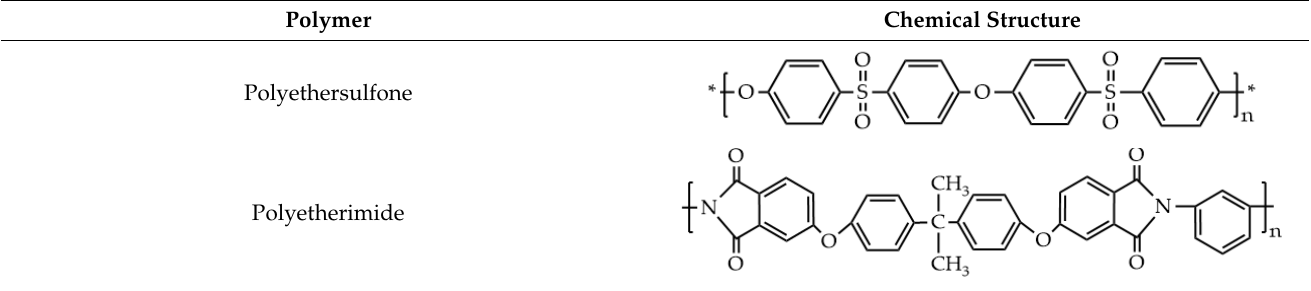
Table 2. The Molecular weight of polymers.